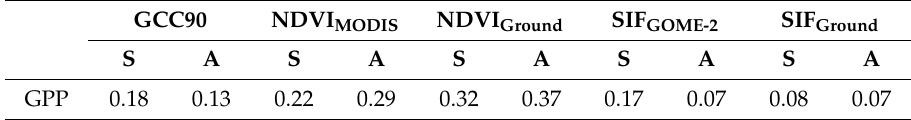
Table 2. The Mean Absolution Error (MAE) between tower-based GPP versus the 90th percentile of the green chromatic coordinates (GCC90), ground-based NDVI (NDVI Ground ) and ground-based SIF (SIF Ground ) in both the spring (S) and autumn season (A). The phenological metrics derived from the tower-based GPP time series were used to define the spring and autumn. All time series are normalized and have a daily step. GCC90 NDVI MODIS NDVI Ground SIF GOME-2 SIF Ground S A S A S A S A S A